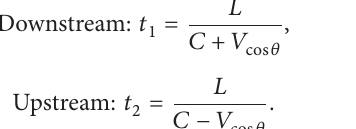
of flow field pointed out that since there might be a reflux near the transducer, the average measurement of velocity of each channel was lower, and the measuring values of flows were lower as